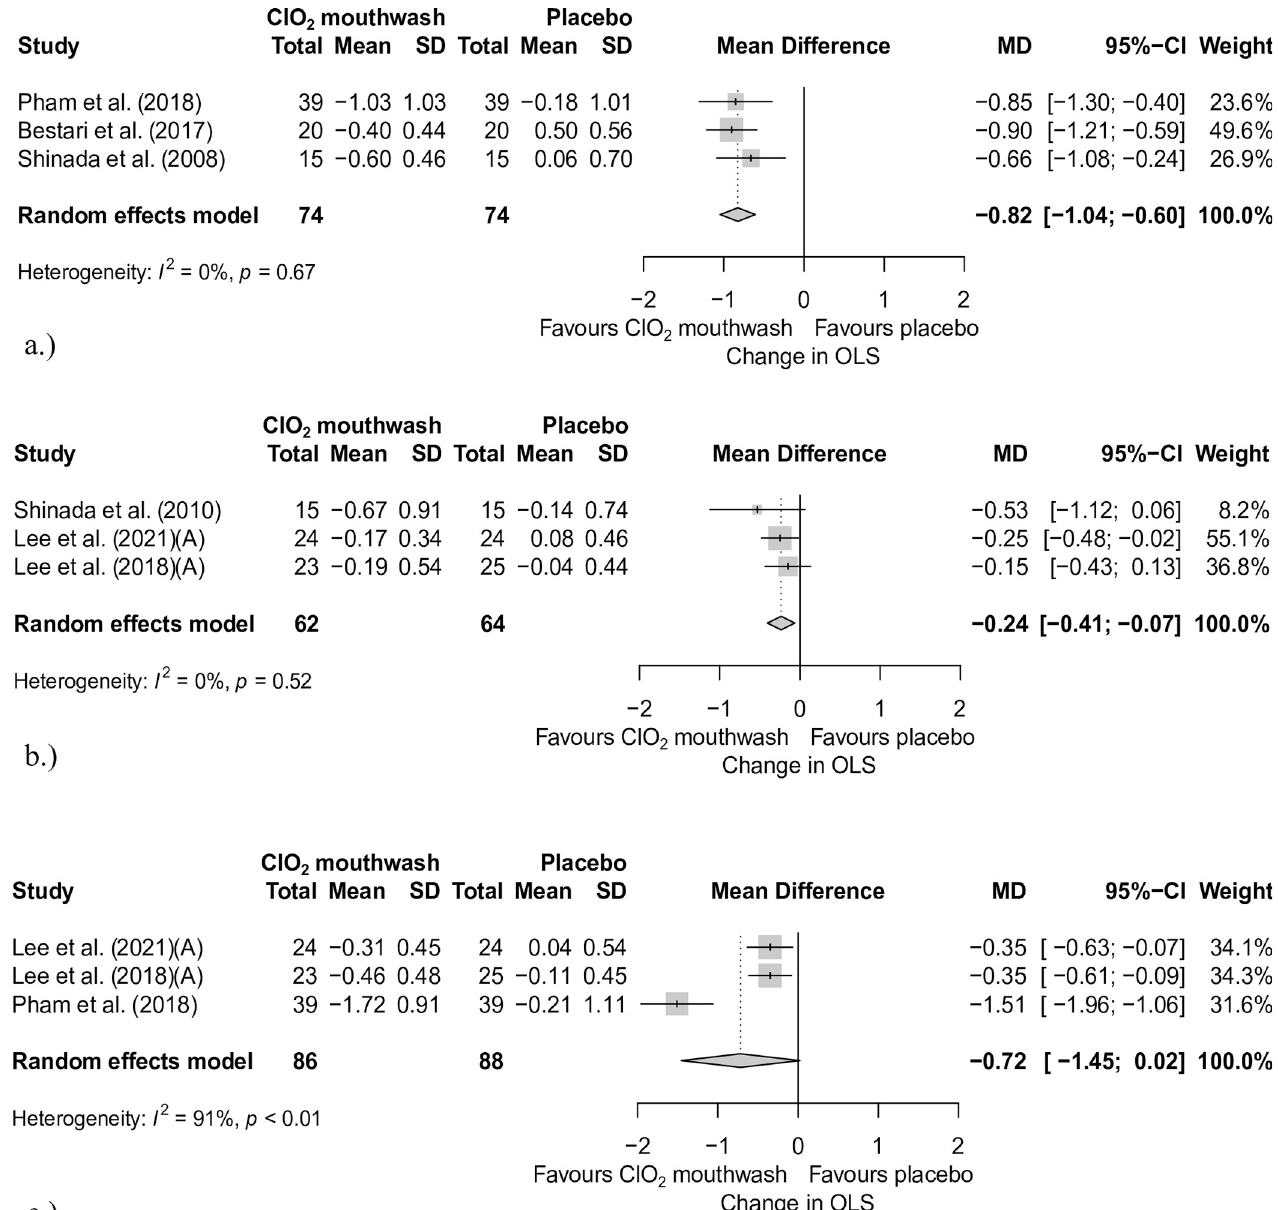
Fig 2. Forest plot analysis of the changes of organoleptic measurement. a. between baseline and within one day with and without ClO 2 mouthwash. b. between baseline and within one week with and without ClO 2 mouthwash. c. between baseline and within two weeks with and without ClO 2 mouthwash. MD: Mean difference; CI: Confidence interval; SD: Standard deviation; ClO 2 : chlorine dioxide; OLS: organoleptic test scores.